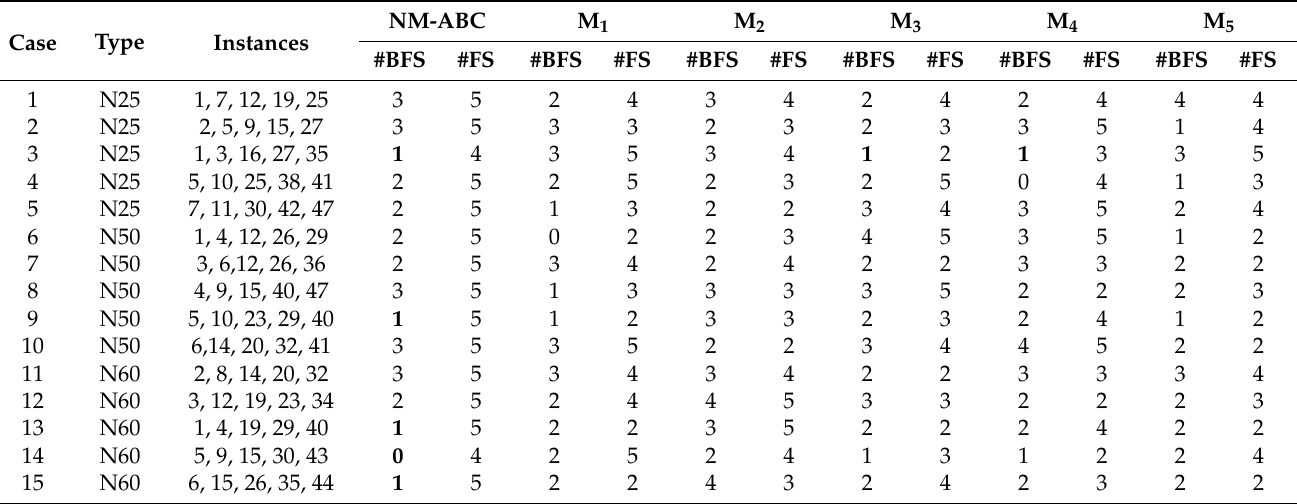
Table 5. Comparison of the number of #both feasible and #feasible solutions obtained by the proposed Artificial bee colony with Nelder Mead method (NM-ABC) and competitor’s methods.